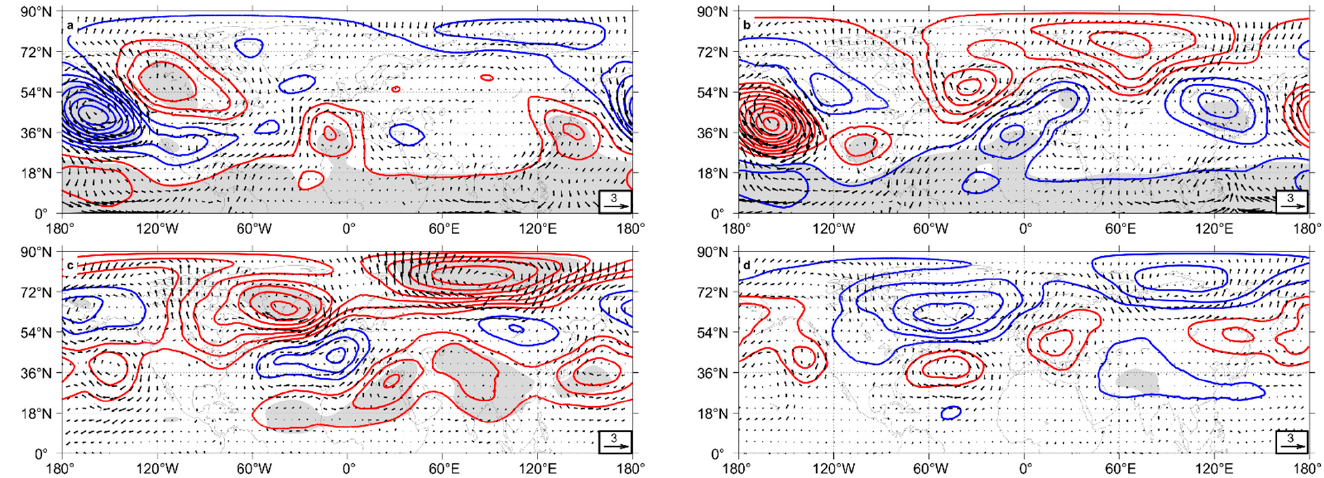
Figure 8. Synthetic analysis of the 500 hPa HGT anomaly field (contour lines, unit: gpm) and 850 hPa wind anomaly field (arrows, unit: m/s) (high ( a )/low ( b ) SST years in the Eastern Equatorial Pacific sea area; high ( c )/low ( d ) SST years in the North Atlantic sea area) (red contour lines mean positive HGT anomaly, blue contour lines mean negative HGT anomaly, the contour lines interval is 5 gpm, grey shaded area through the test of significance of 95%).